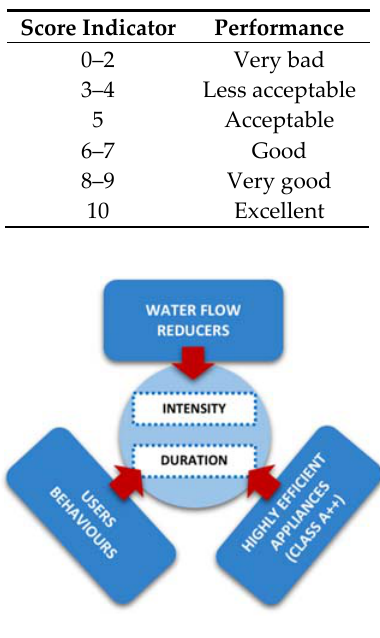
Figure 2. Parameters affecting pulse intensity and